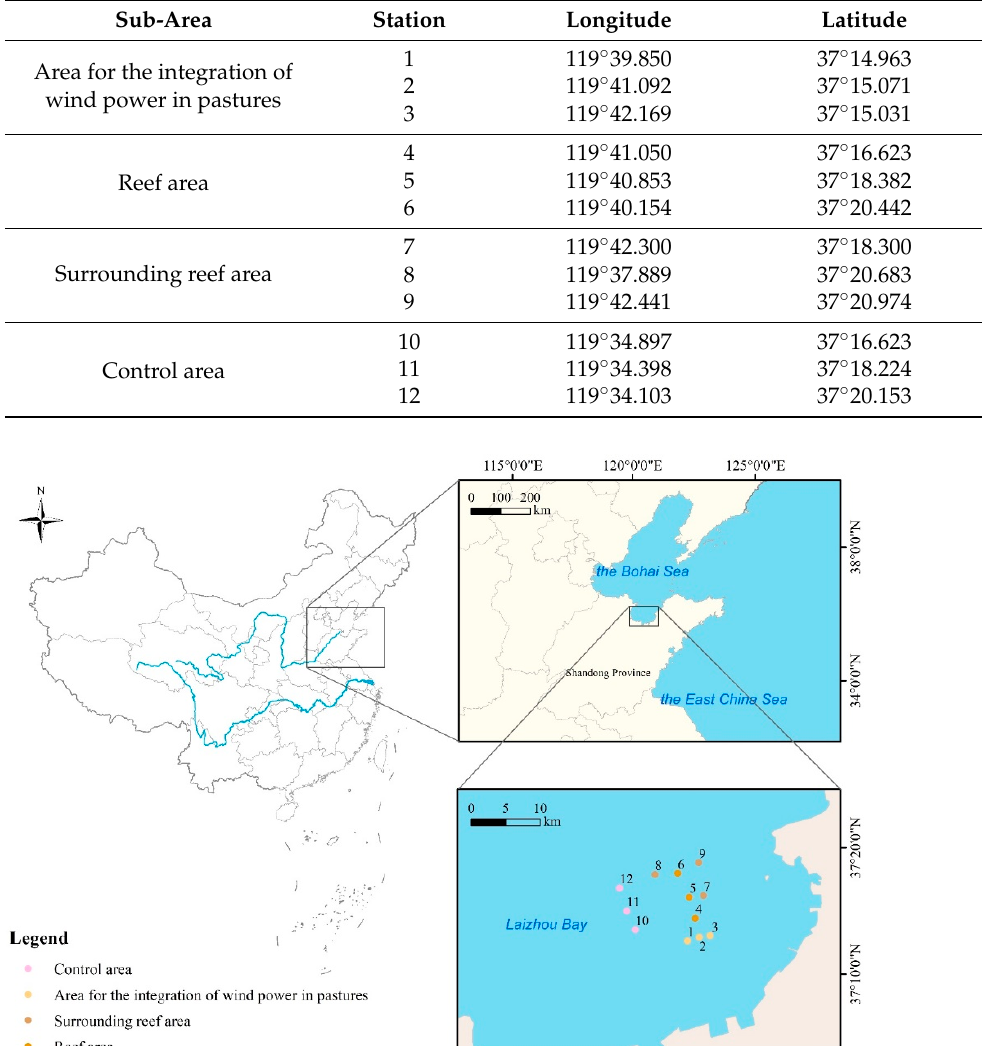
Table 1. Sampling station coordinates.